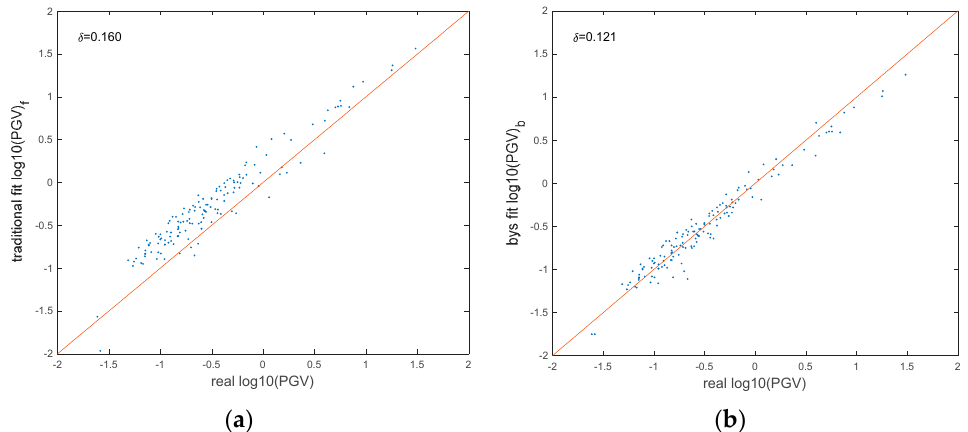
Figure 6. Comparison of true PGV with conventional fitted predictions ( a ) and Bayesian-inference- based predictions ( b ).